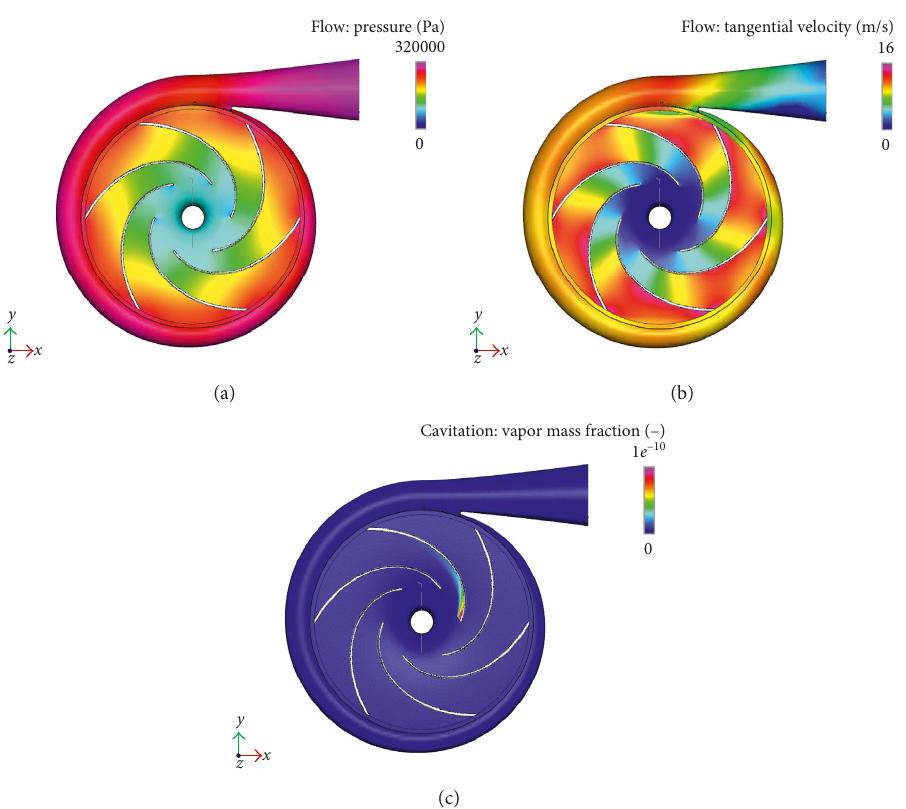
Figure 3: Prototype pump flow field simulation. (a) Pressure contour diagram. (b) Velocity contour diagram. (c) Cavitation contour